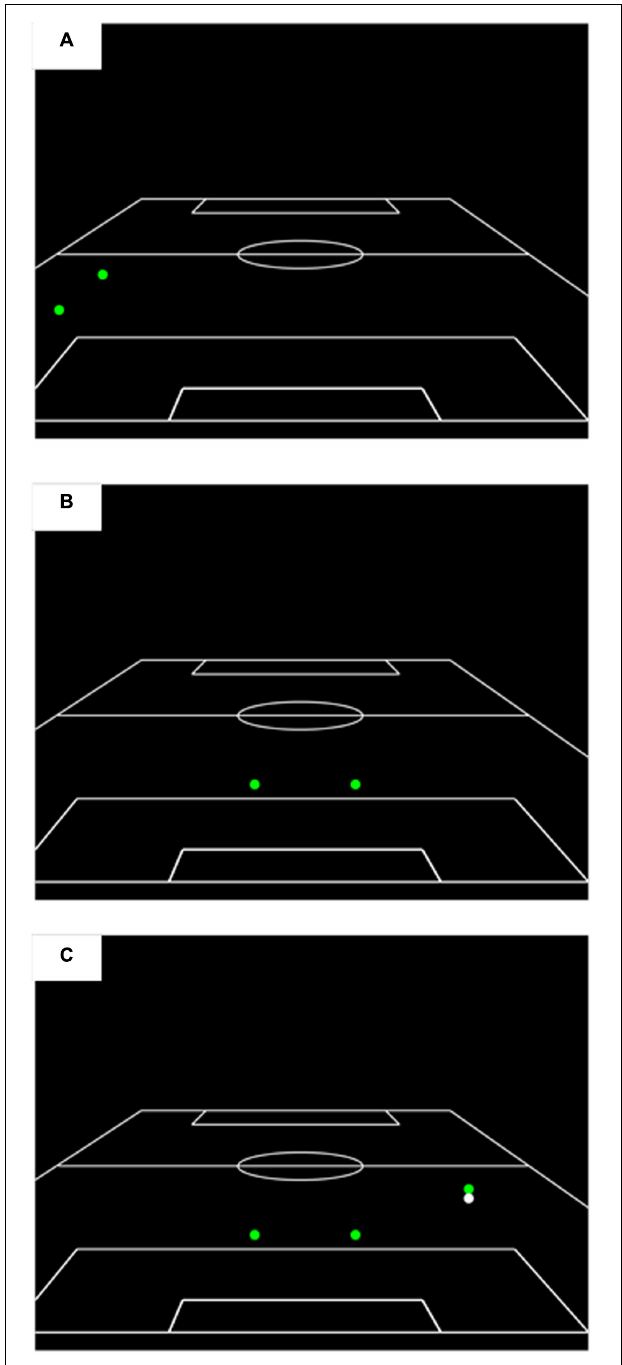
FIGURE 2 | A schematic illustration of the information presented during the recognition phase in (A) peripheral players only, (B) central offensive players only, and (C) central offensive players plus ball and player in possession